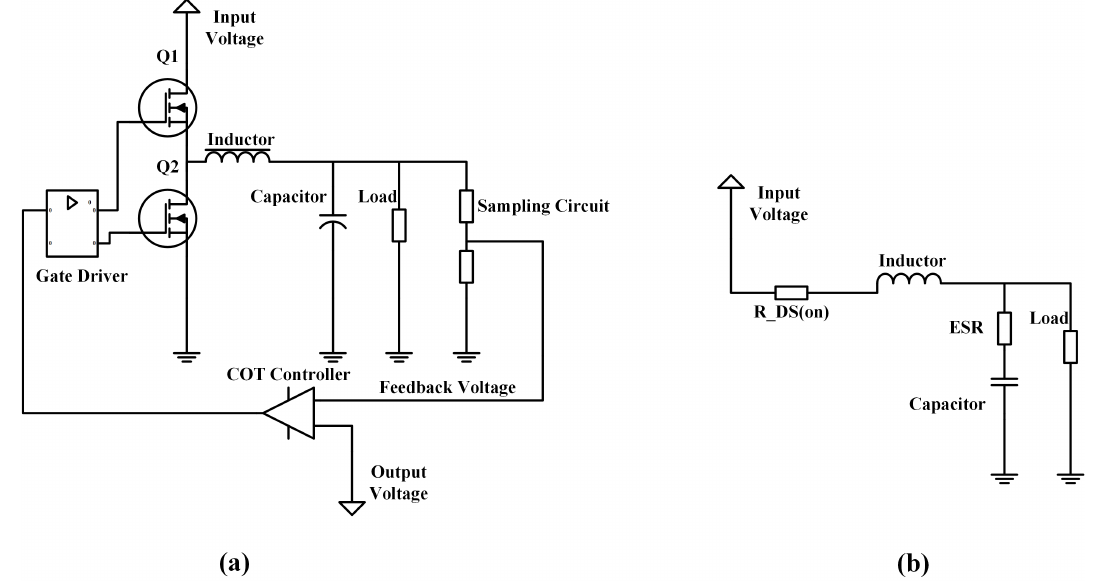
Figure 2. The schematic diagram of the Buck circuit. ( a ) A typical Buck circuit; ( b ) simplified form of ( a ). ESR: equivalent serial resistance; COT: constant